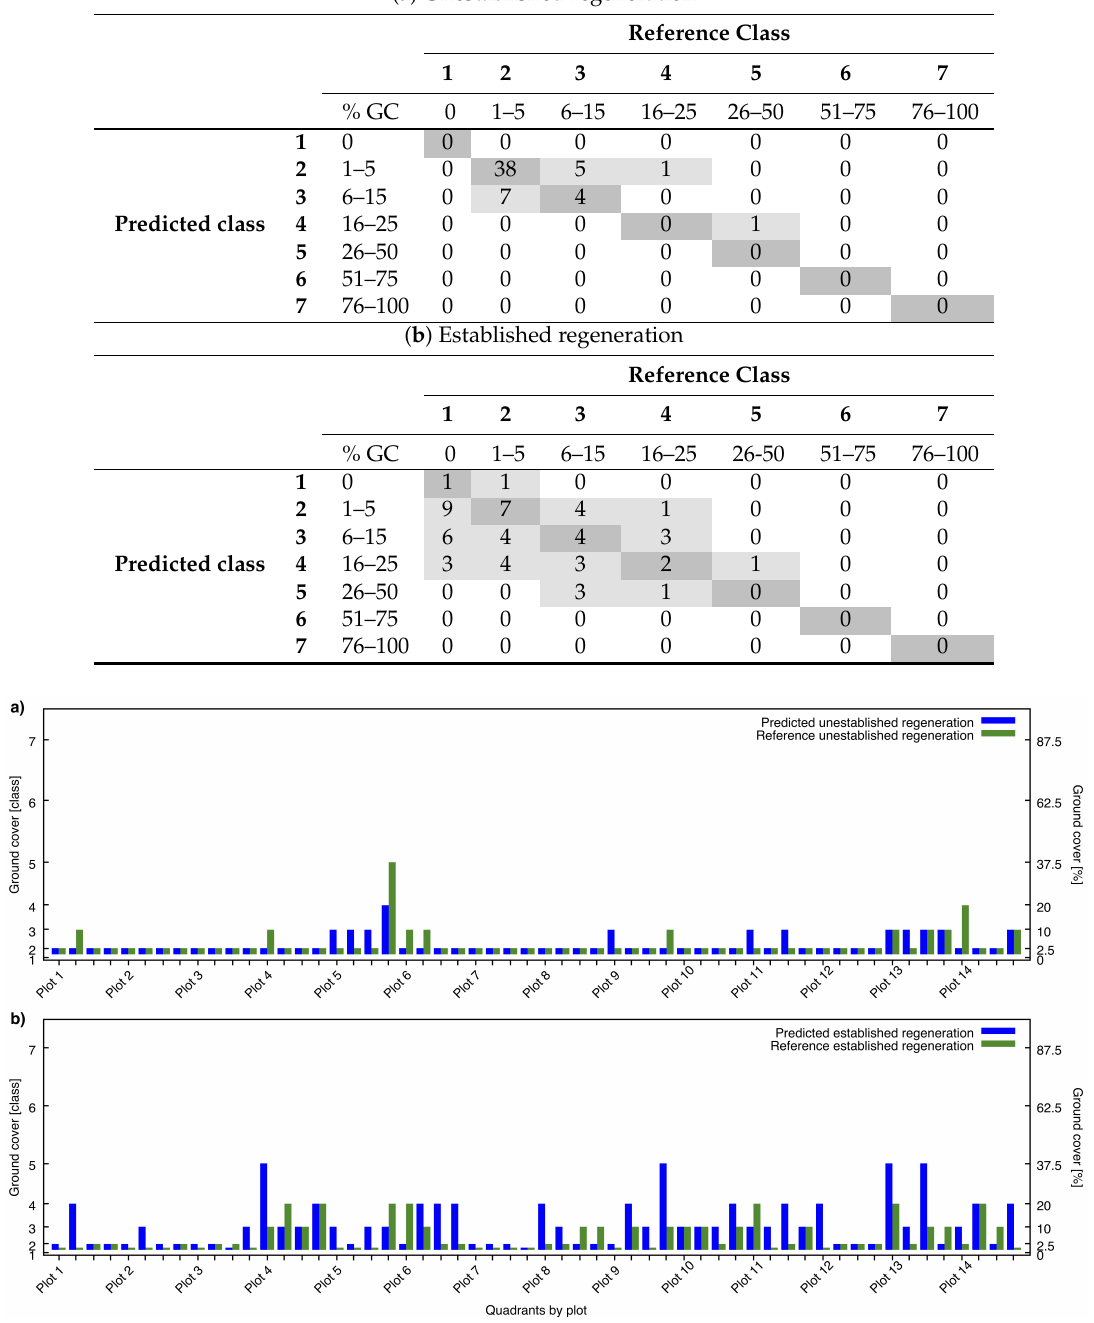
Figure 5. Charts showing the predicted ground cover (blue) versus the field reference (green) for each individual quadrant. The quadrants are sorted by plot as indicated on the x-axis. The marking of the y-axis on the left side indicates the classes of ground cover. The marking on the right side indicates percentage of ground cover, given as the centre values of each class. Part ( a ) covers the unestablished regeneration and part ( b ) the established